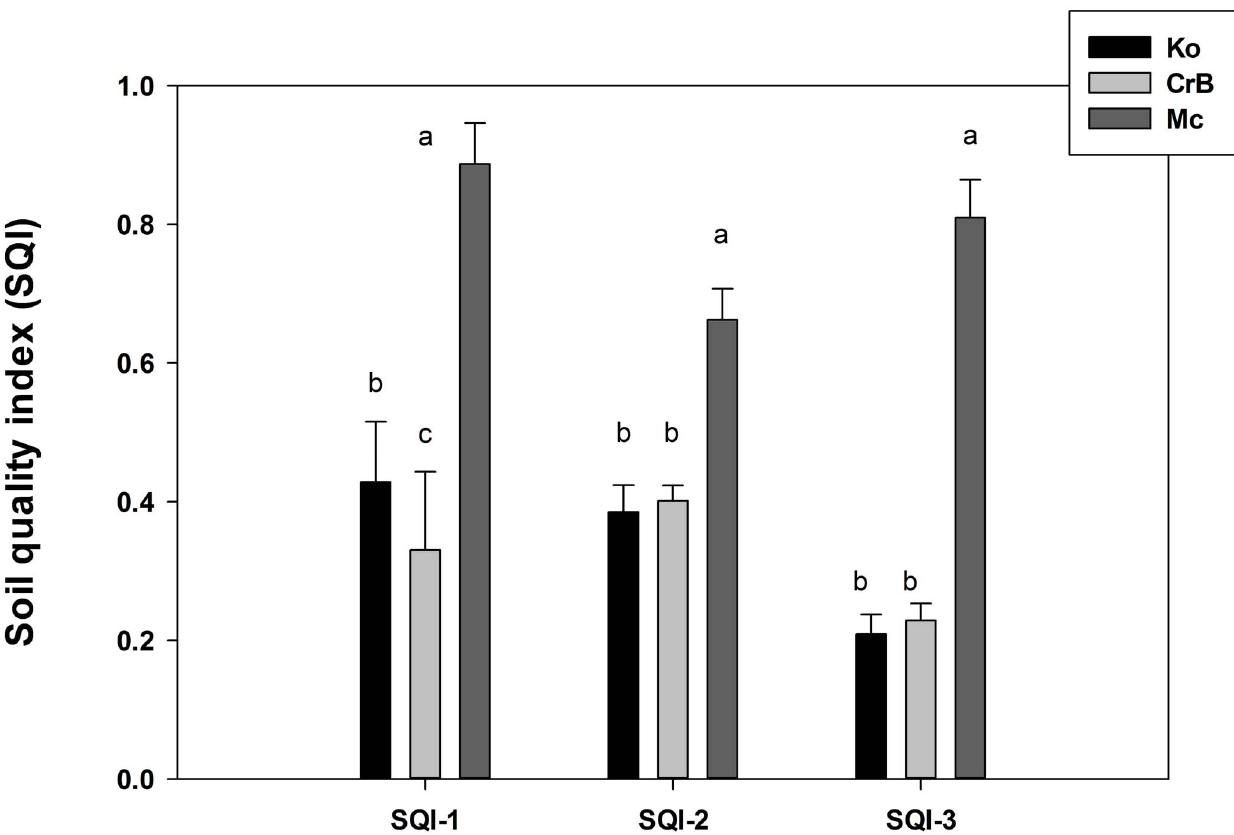
Figure 2. Overall soil quality index (SQI) values under different soil types. Different letters indicate significant differences at p , 0.05 level for particular indexing method.